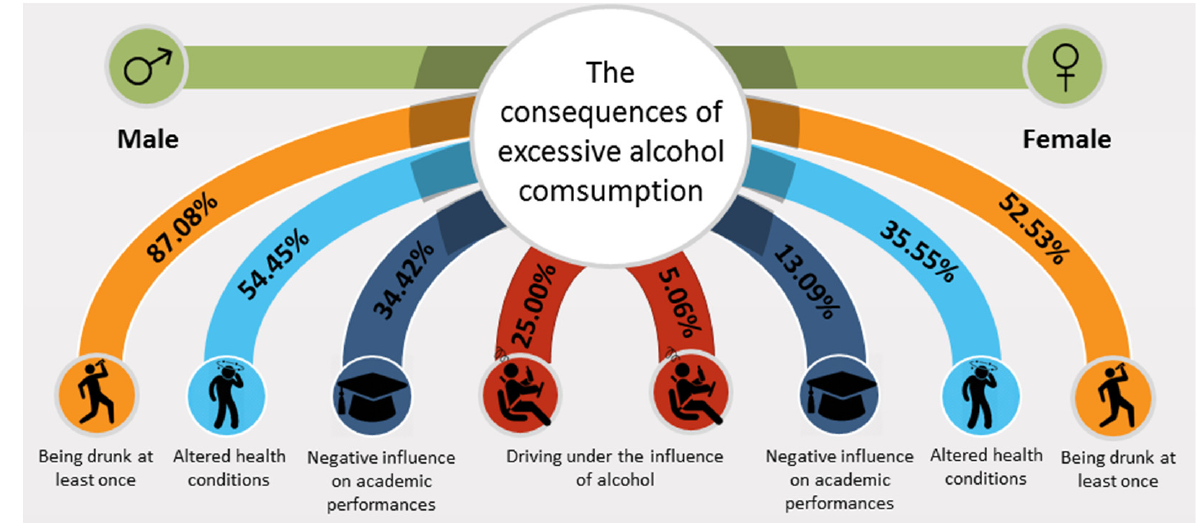
Figure 2. The negative consequences of excessive alcohol consumption among students.